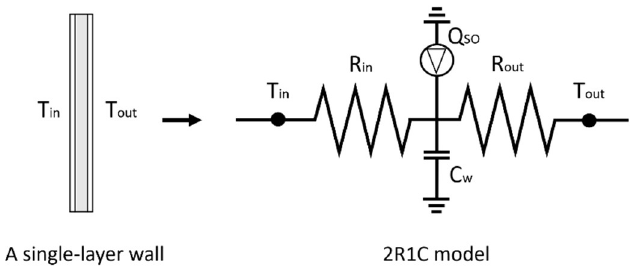
Figure 3. RC model for a single-layer wall. Table 6. Physical parameters in RC models.